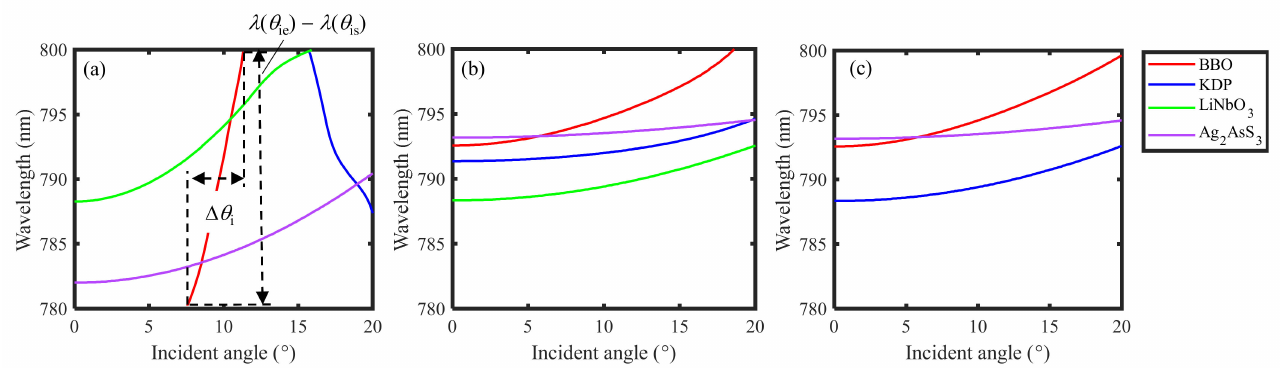
Figure 12. The angle dependence of central wavelength λ P . ( a ) p-s polarization; ( b ) p-p polarization; ( c ) s-s